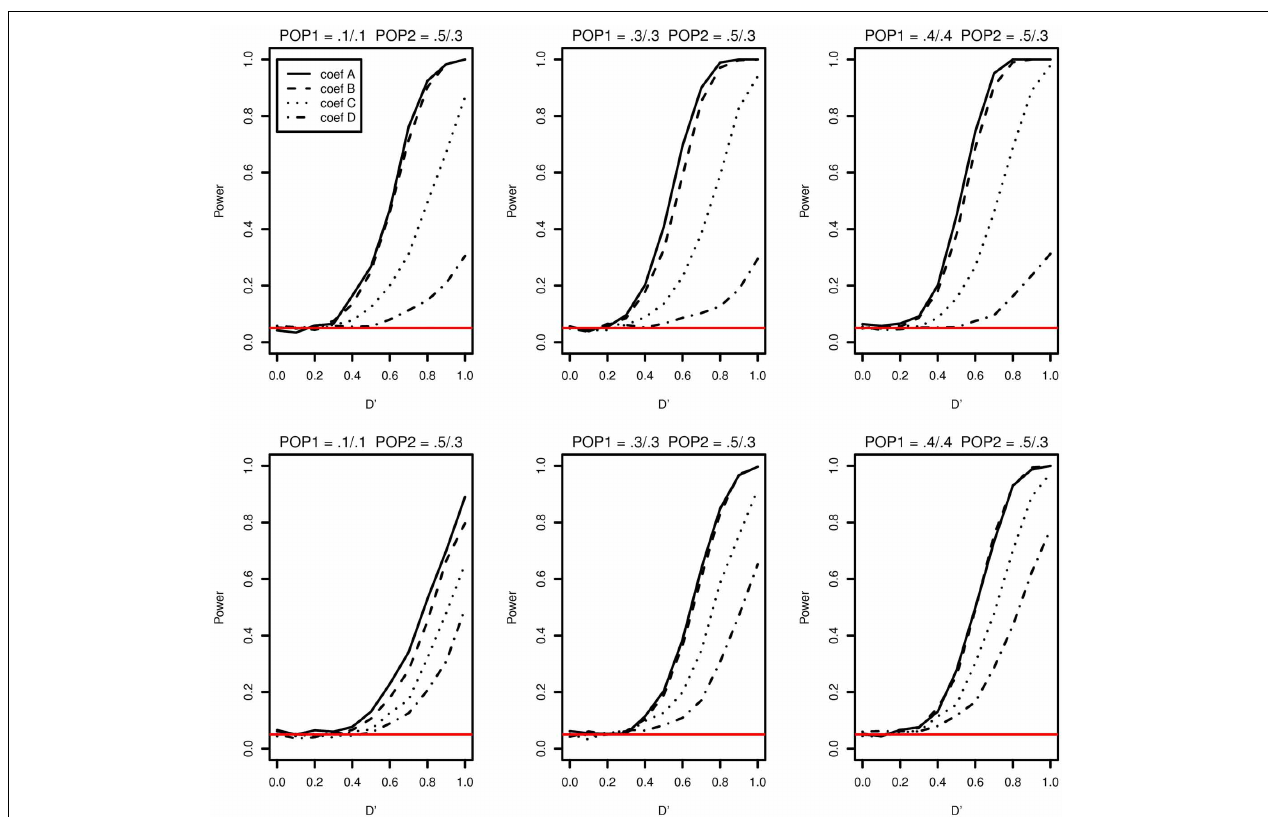
β 2 = 0 . 25, and β 12 = 0 . 75, coef C : β 1 = 0 . 5, β 2 = 0 . 5, and β 12 = 0 . 5, coef D : = 0 . 5 and σ 2 = 1. Plots in the β 1 = 0 . 75, β 2 = 0 . 75, and β 12 = 0 . 25, and σ 2 a e bottom row: β 0 = 0 for Population 1 with the regression coefficients as above and β 0 = β 1 = β 2 = β 12 = 0 . 2forPopulation2,and σ 2 a = 0 . 5and σ 2 e = 1forboth populations. The red horizontal line indicates the 0.05 significance